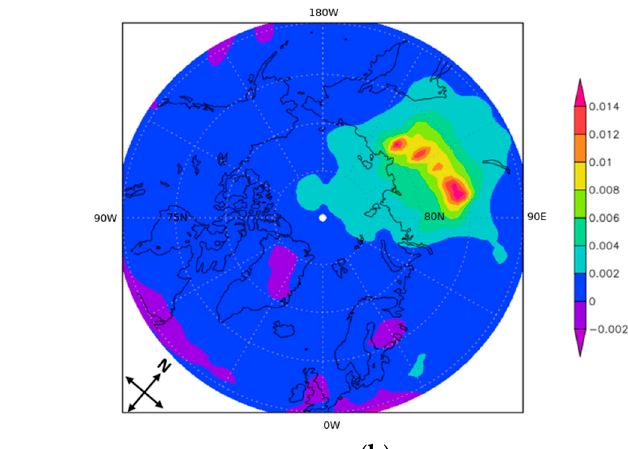
Figure 12. The ensemble averaged BC optical thickness anomaly of 550 nm in ( a ) July and ( b ) August.